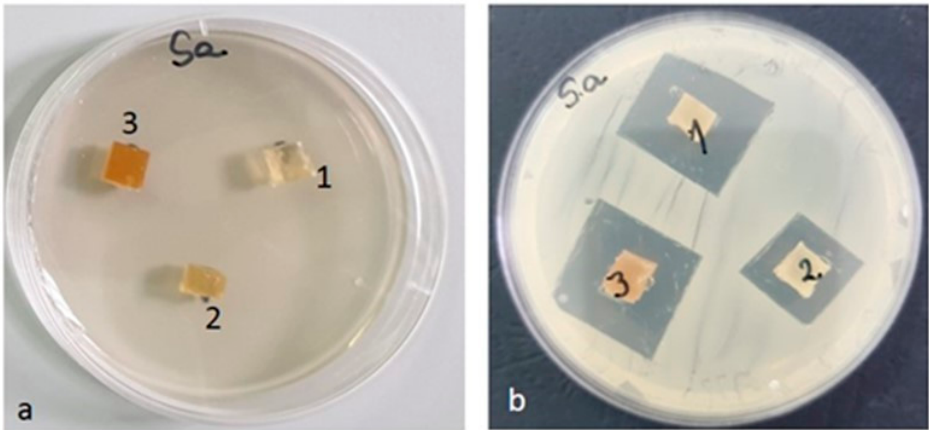
Figure 16. Staphylococcus aureus ATCC 25923 ( a ) zero (initial) moment, ( b ) inhibition after 48 h of incubation.